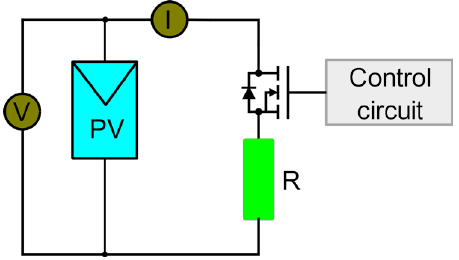
Figure 11. Schematic of an electronic load tracer with a MOSFET transistor. Source [16], own elaboration.